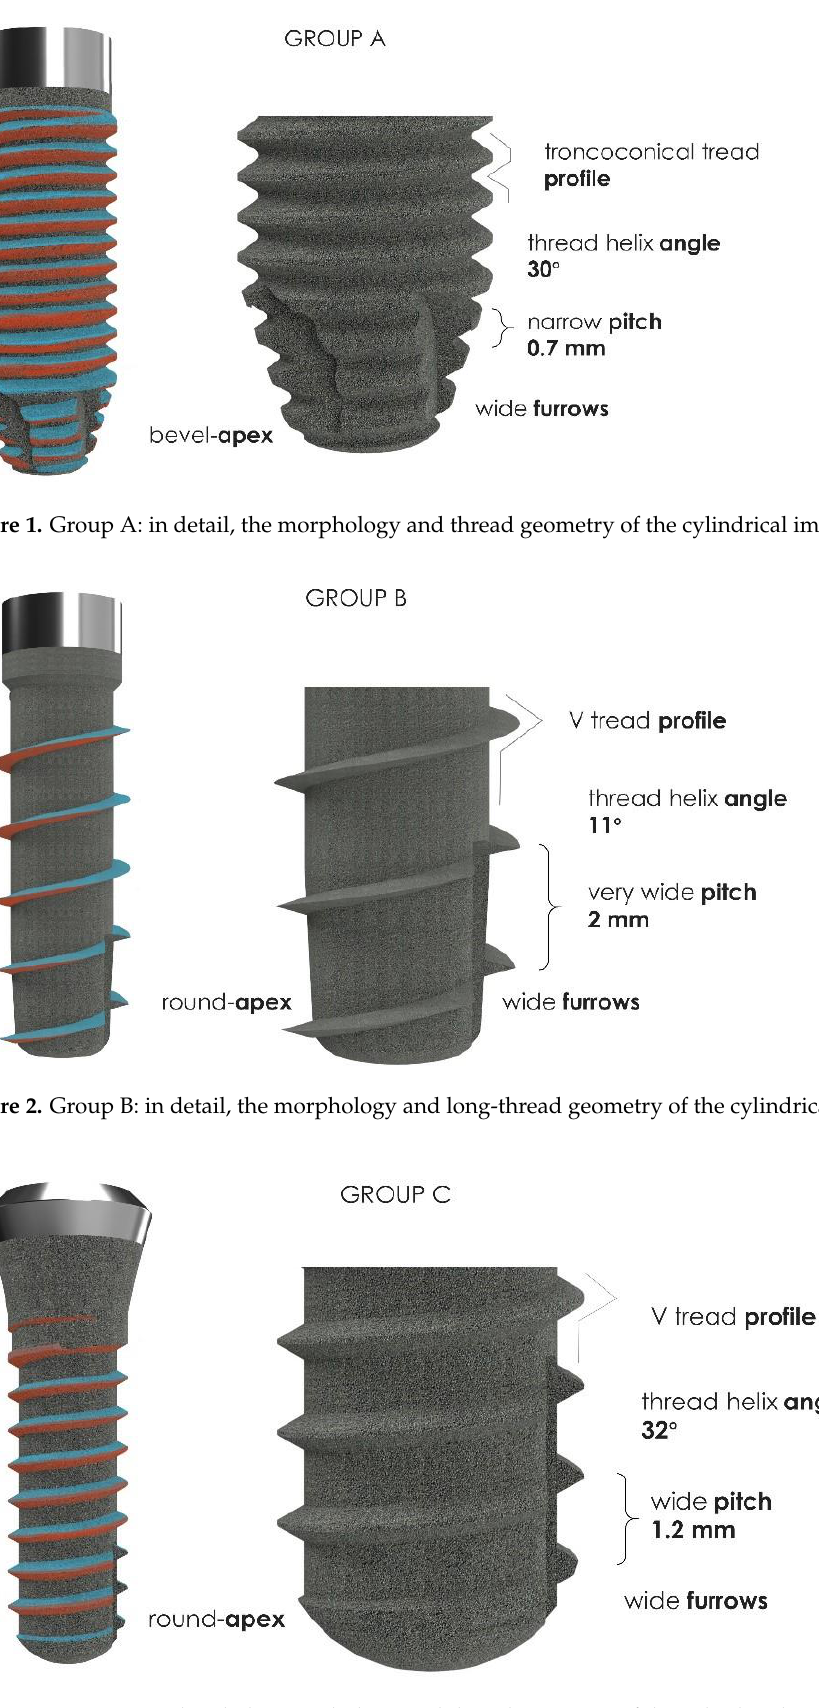
Figure 4. Group D: in detail, the morphology and thread geometry of the external hexagon cylin- drical implants.